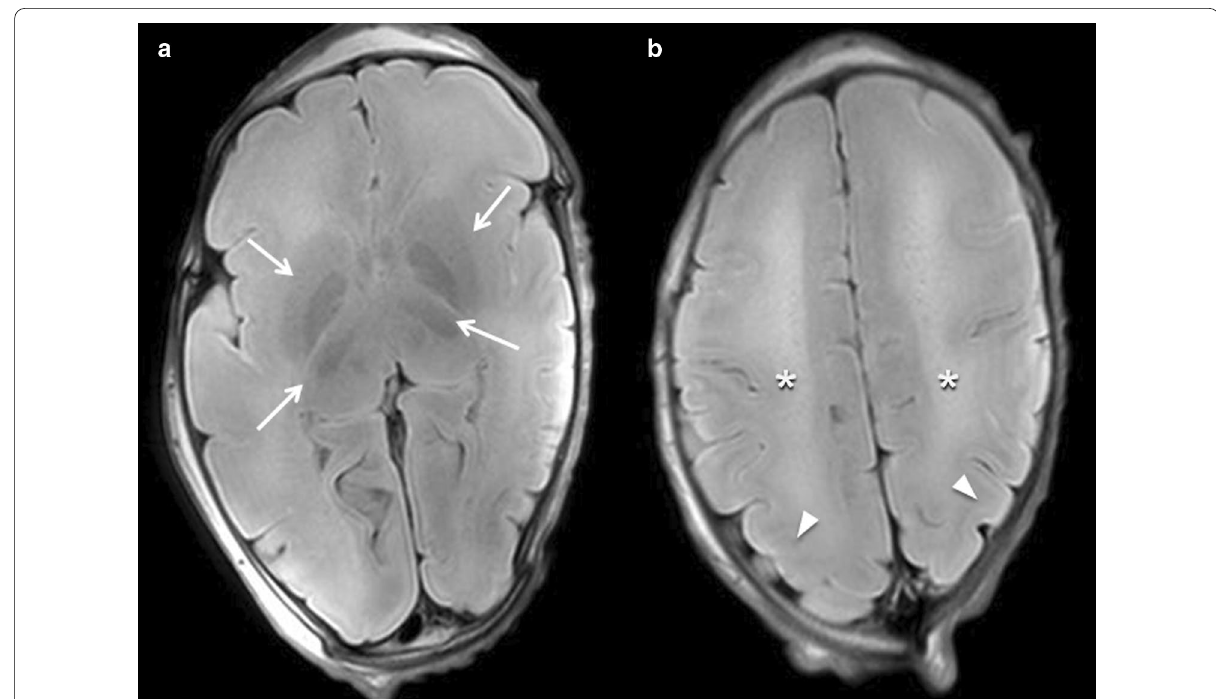
Fig. 4 Normal cerebral lamination in a 34‑week foetus. Axial T2W images a better grey‑white matter differentiation, deep grey matter (arrows), b cerebral cortex (arrowheads), centrum semiovale (asterisks)